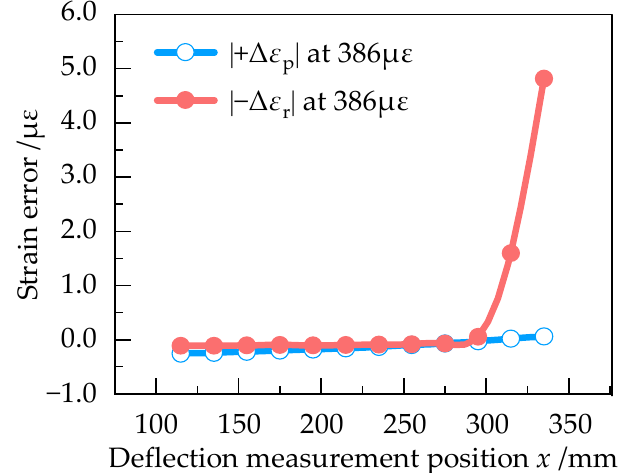
Figure 10. Curve of |+ Δε p | and | −Δε r | at 386 με .